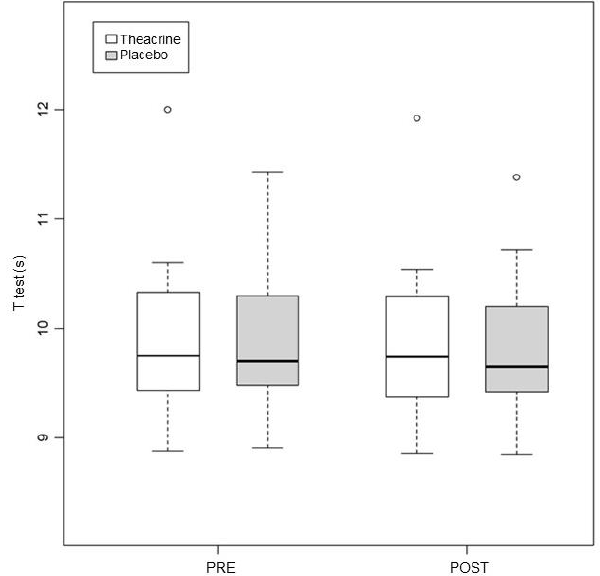
Figure 3. Alterations in performance in the T test in the first and second assessments. Values ex- pressed in median – interquartile interval. s = seconds.